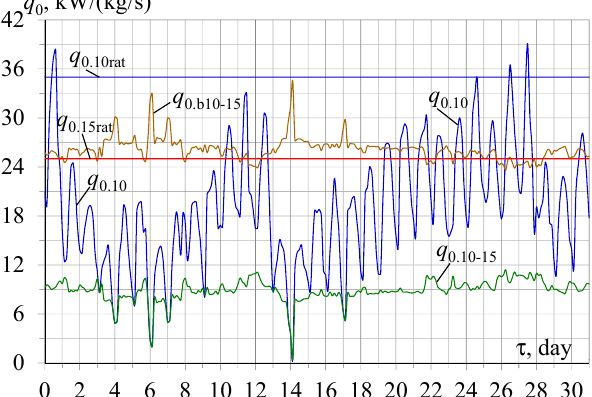
Figure 2. Current values of specific refrigeration capacities q 0.10 required for outdoor air conditioning to 10 ◦ C, refrigeration capacities q 0.10-15 for subsequent air conditioning from 15 ◦ C to 10 ◦ C, and available booster values q 0.b10-15 remained for outdoor air conditioning to 15 ◦ C: q 0.10–15 = q 0.10 − q 0.15 ; q 0.b10-15 = q 0.10 − q 0.10-15